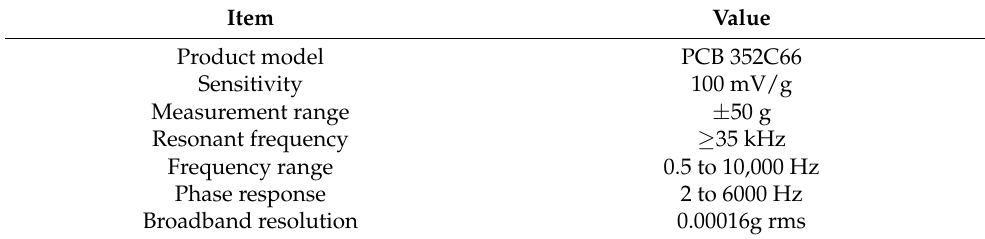
Table 2. Detailed parameters of the PCB accelerometers.